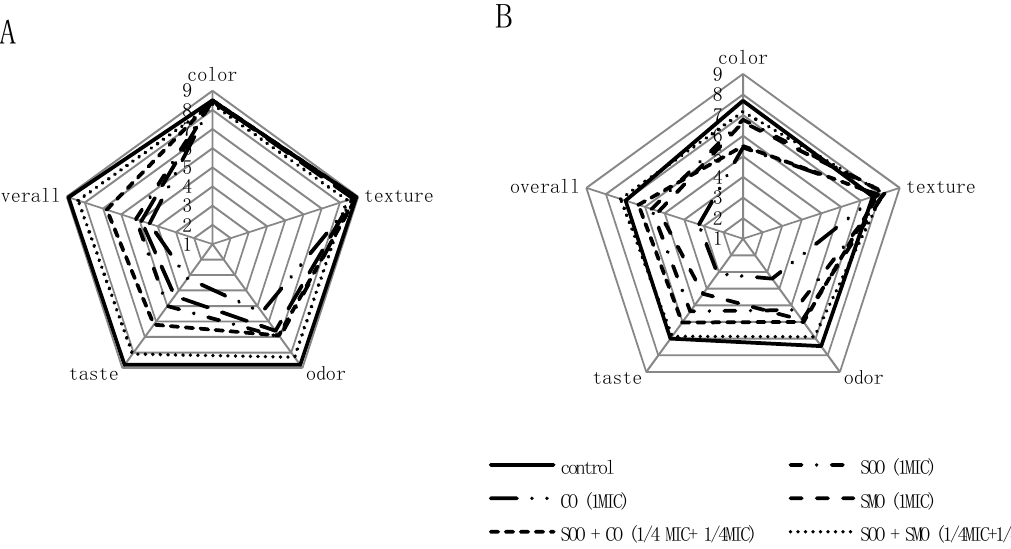
Figure 3. Changes in the sensory quality of a vegetable mixture treated by the addition of EOs or a mixture of EOs ( A ) after 30 min, ( B ) after 4 days of storage.